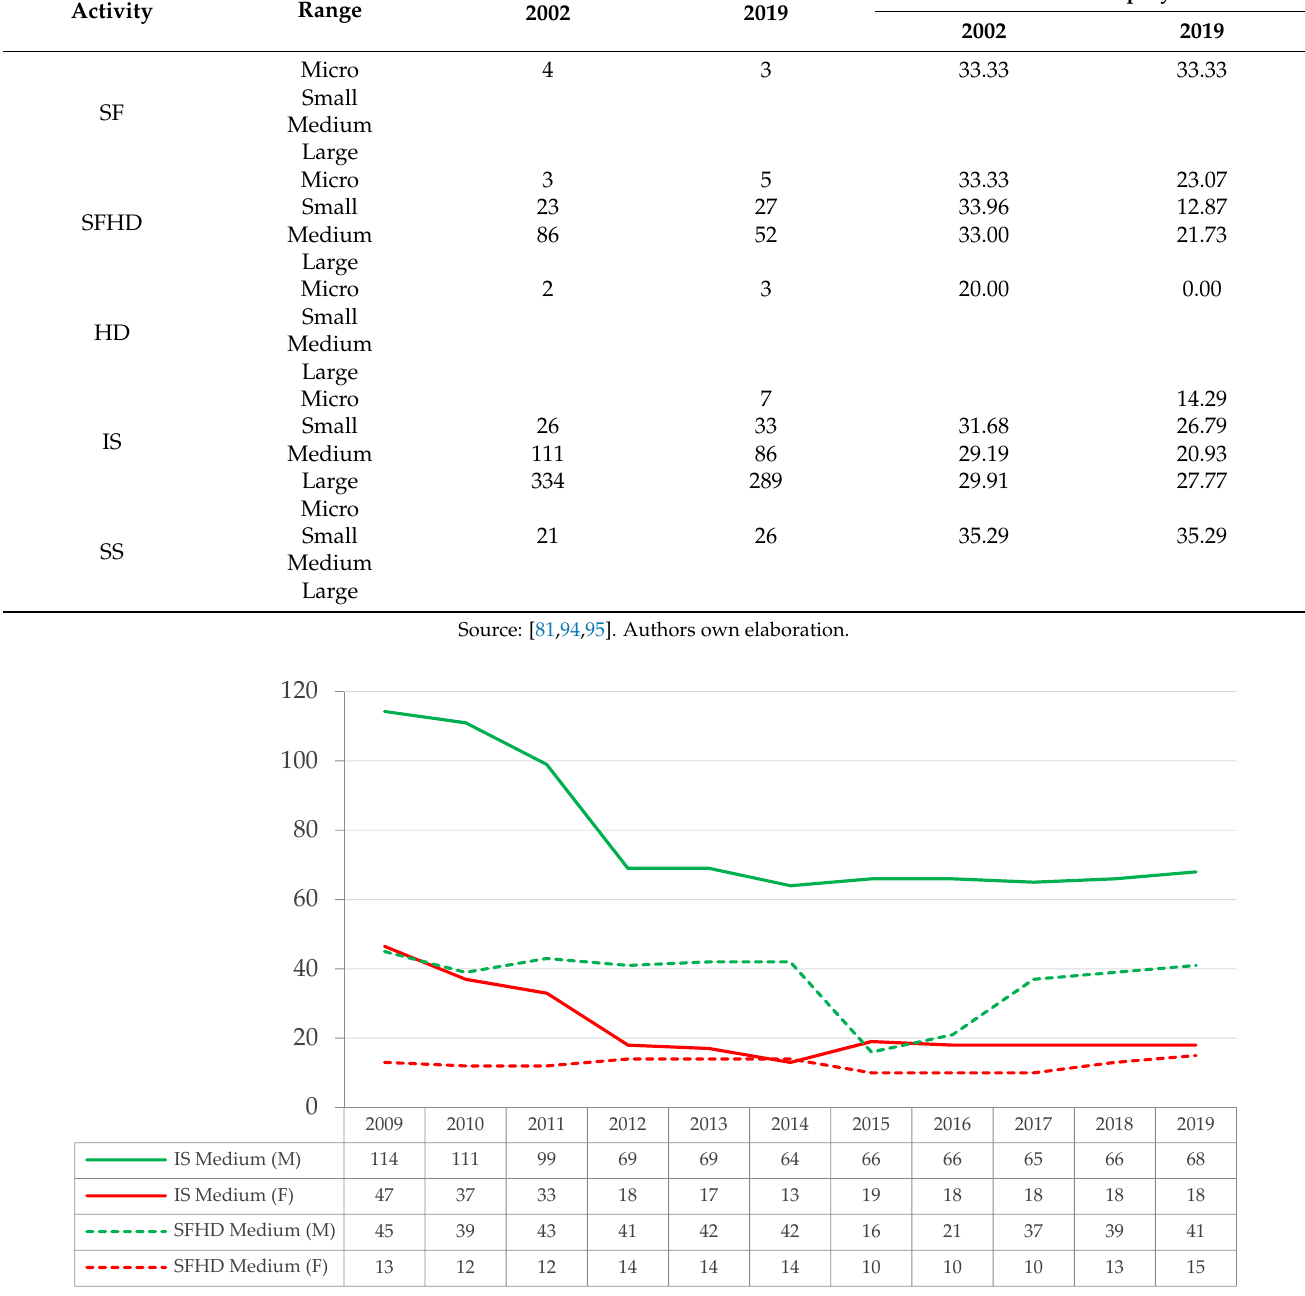
Figure 10. The evolution of male and female employment between 2009 and 2019. Source: [81]. Authors own elaboration.